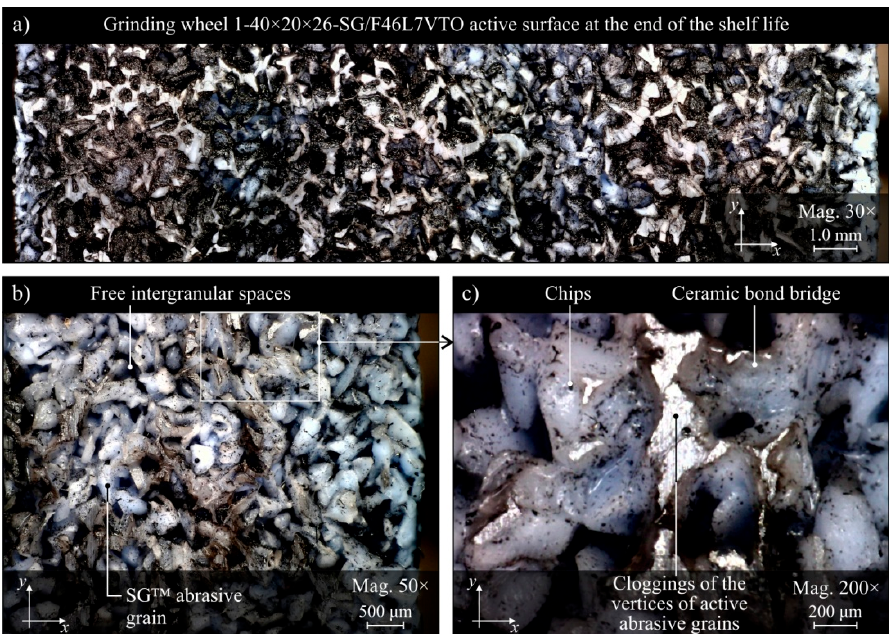
Figure 13. Microscope images of the grinding wheel active surface after machining using the hybrid method of cooling and lubrication (centrifugal MQL + CAG), recorded with the Dino-Lite Edge AM6715MZT digital measuring microscope: ( a ) magnification 30×; ( b ) magnification 50×; ( c ) magnification 200×.